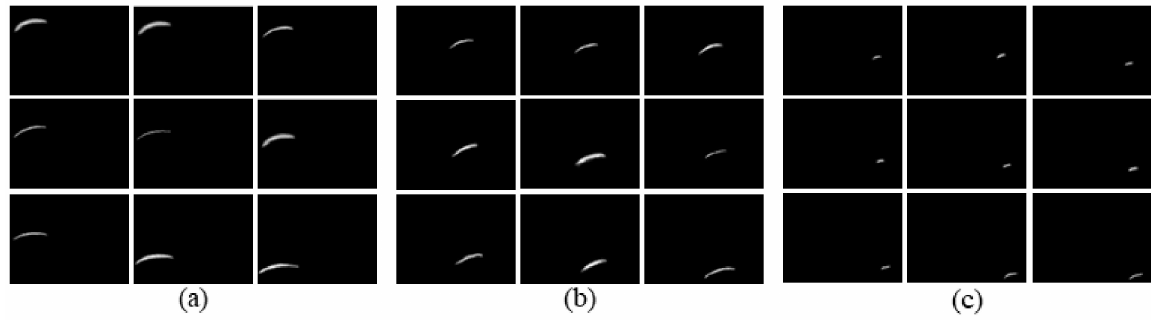
Figure 13. Three-phase Fault Trace. ( a ) R phase, ( b ) S phase, ( c ) T phase.